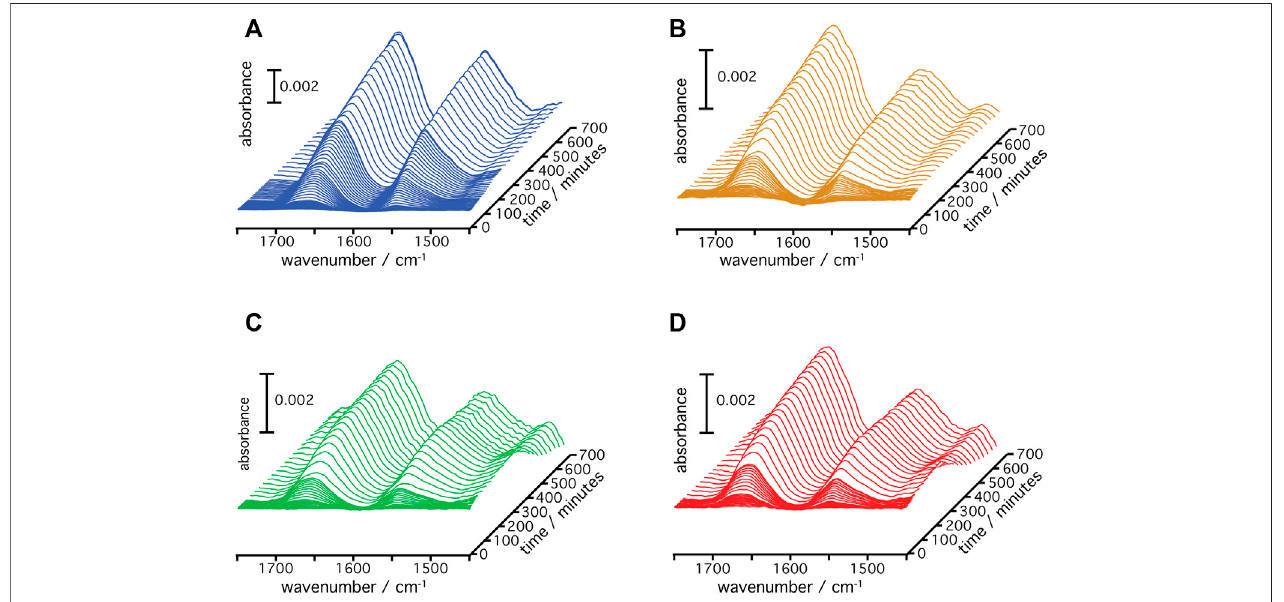
FIGURE 2 | Time-resolved SEIRA spectra of (A) Hs BR, (B) Cr ChR2, (C) Hs SRI, and (D) Hs SRII during the cell-free expression and insertion into the DMPC nanodiscs are shown.